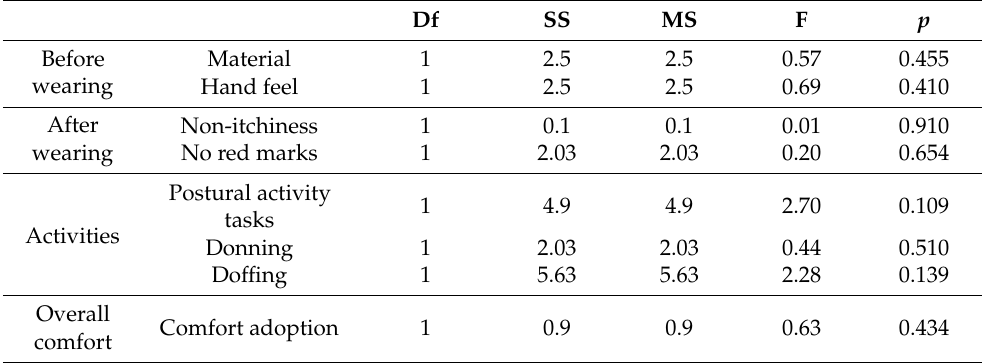
Table 4. One-way ANOVA summary table comparing comfort assessment between compression sock types (clinical vs.